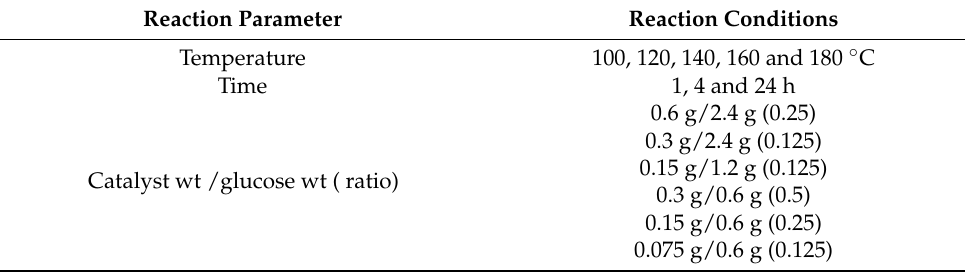
Table 2. Reaction conditions tested for the obtention of 5-HMF from